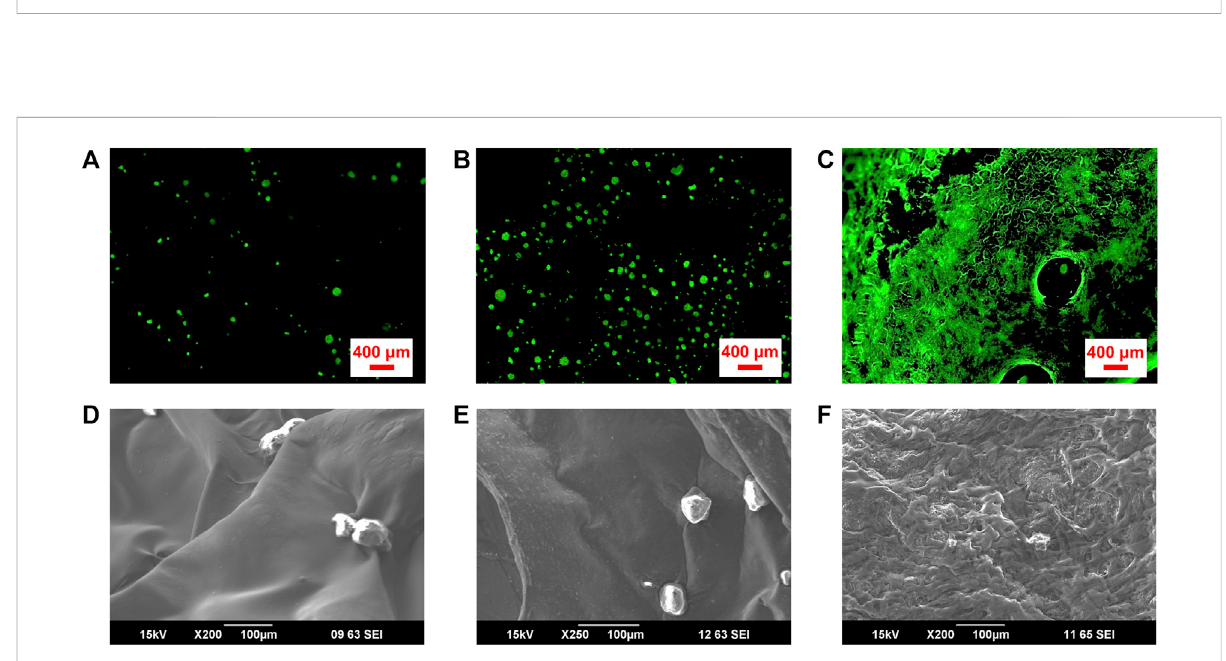
FIGURE 4 Attachment and survival of ADSCs seeded on 3D printed Alg/Gel scaffolds comprising different GO concentrations. Fluorescence microscope images of live (Calcein AM; green), and dead (PI; red) ADSCs cultured on porous 3D printed scaffolds with fi nal compositions of (A) 2% (w/w) Alg, (B) 2%/0.05% (w/w) Alg/GO, and (C) 2%/0.3% (w/w) Alg/GO following 1-day culture, respectively. (D – F) SEM images of ADSCs on 3D printed scaffolds with fi nal compositions of 2% (w/w) Alg, 2%/0.05% (w/w) Alg/GO and 2%/0.3% (w/w) Alg/GO following 1-day culture,